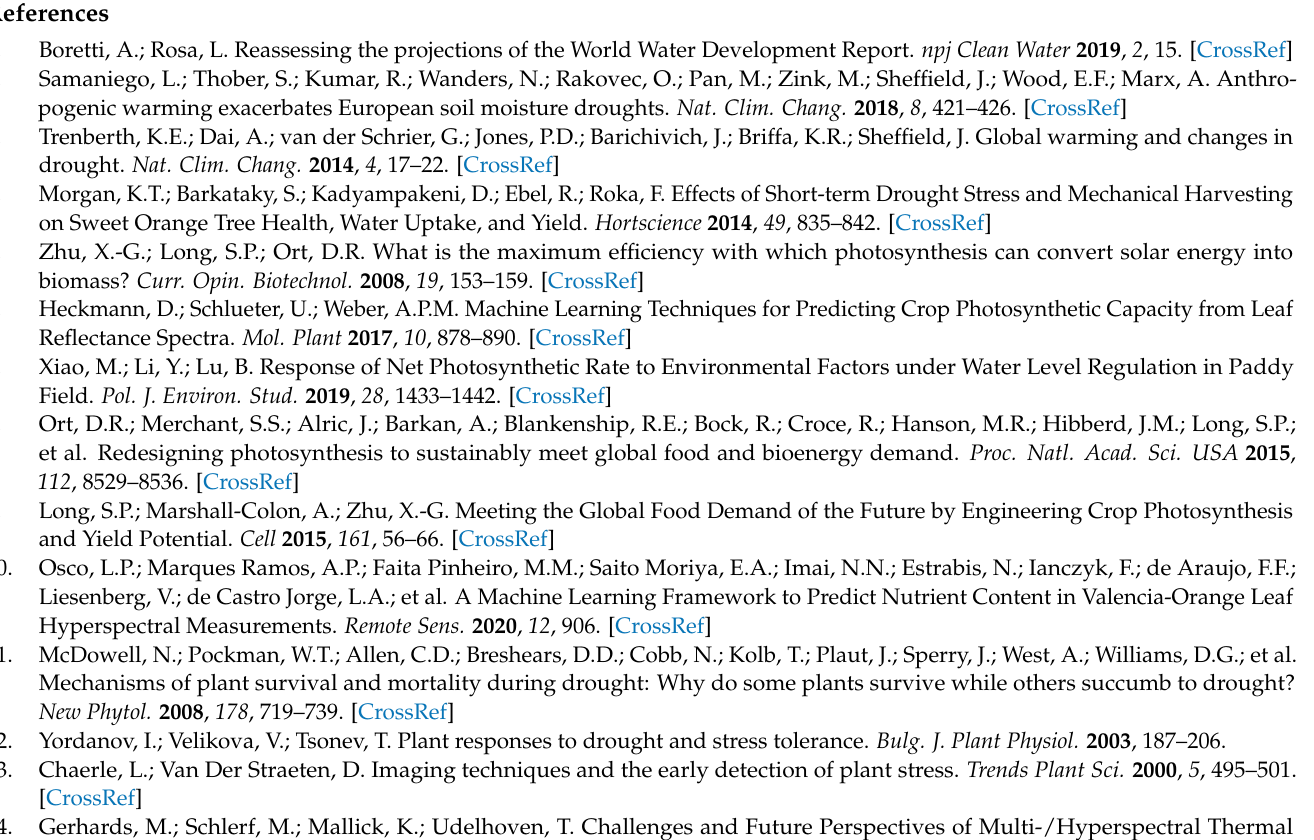
Table S5: ANOVA results for the spectral parameters corresponding to Figure 7. SS: Sum of squares, DF: Degree of freedom; MS: Mean square. Table S6: ANOVA results for the spectral parameters corresponding to Table 2. SS: Sum of squares, DF: Degree of freedom; MS: Mean